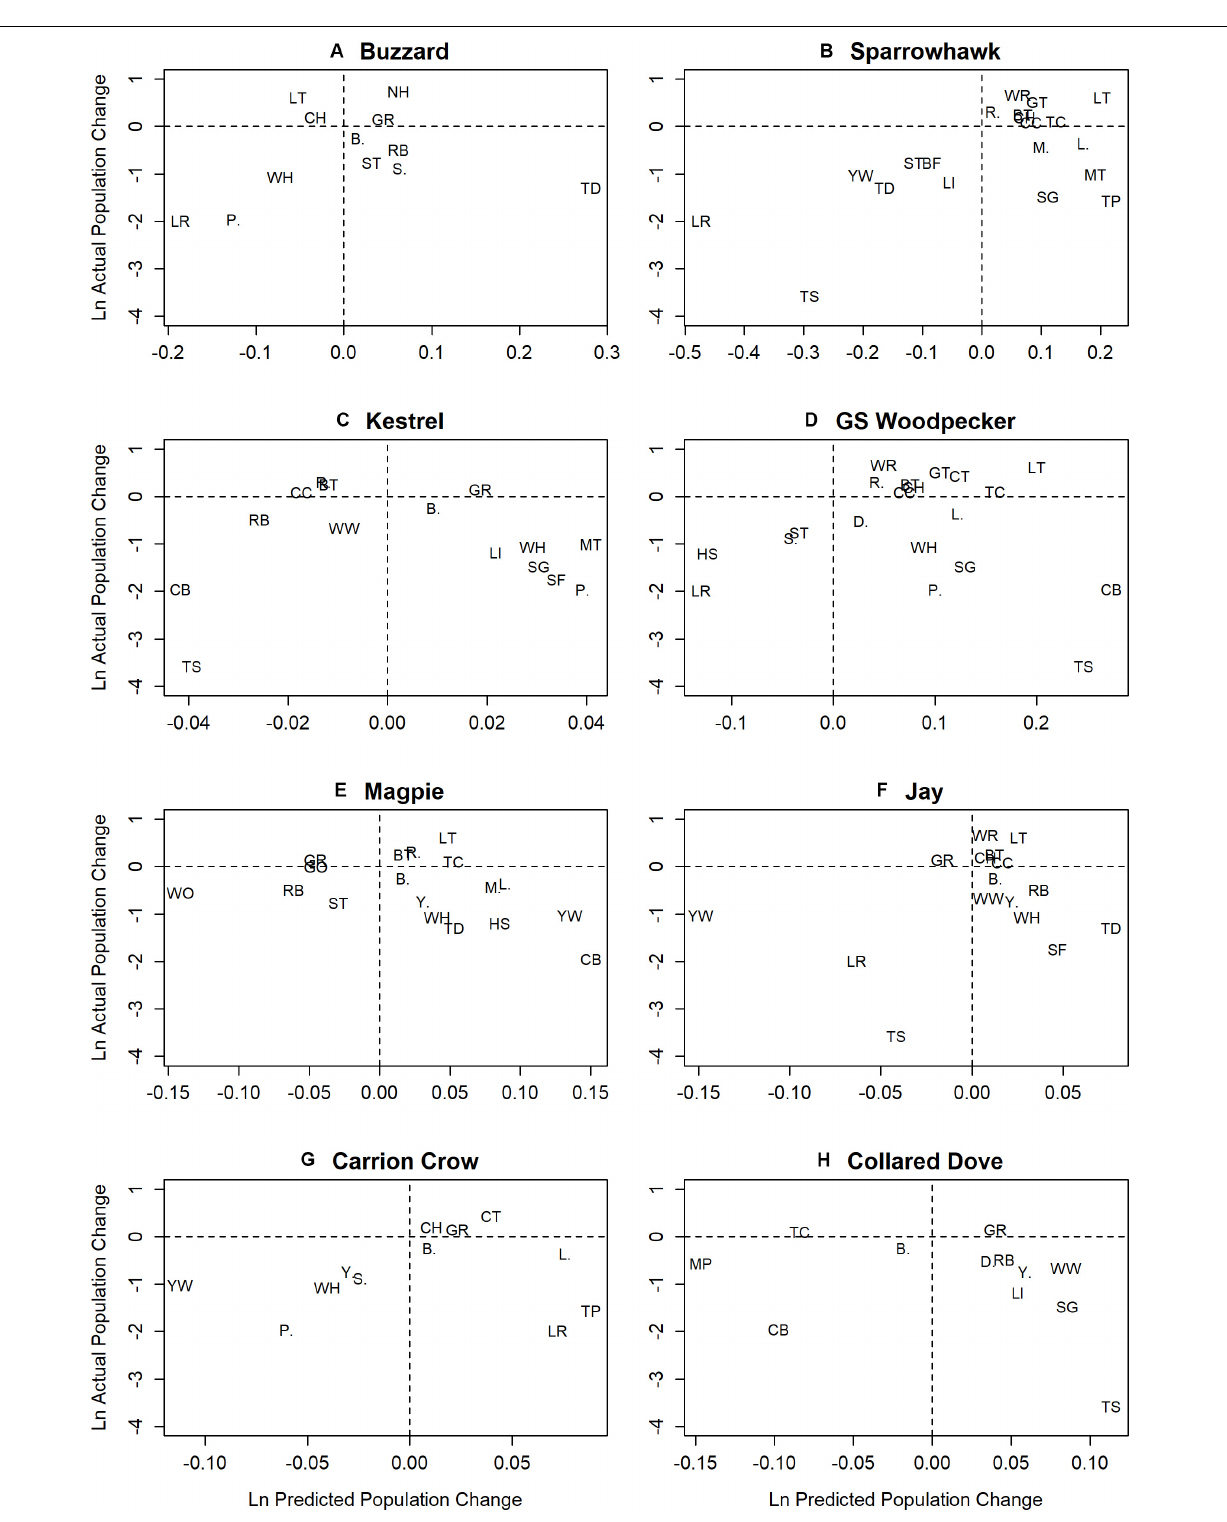
Frontiers in Ecology and Evolution |